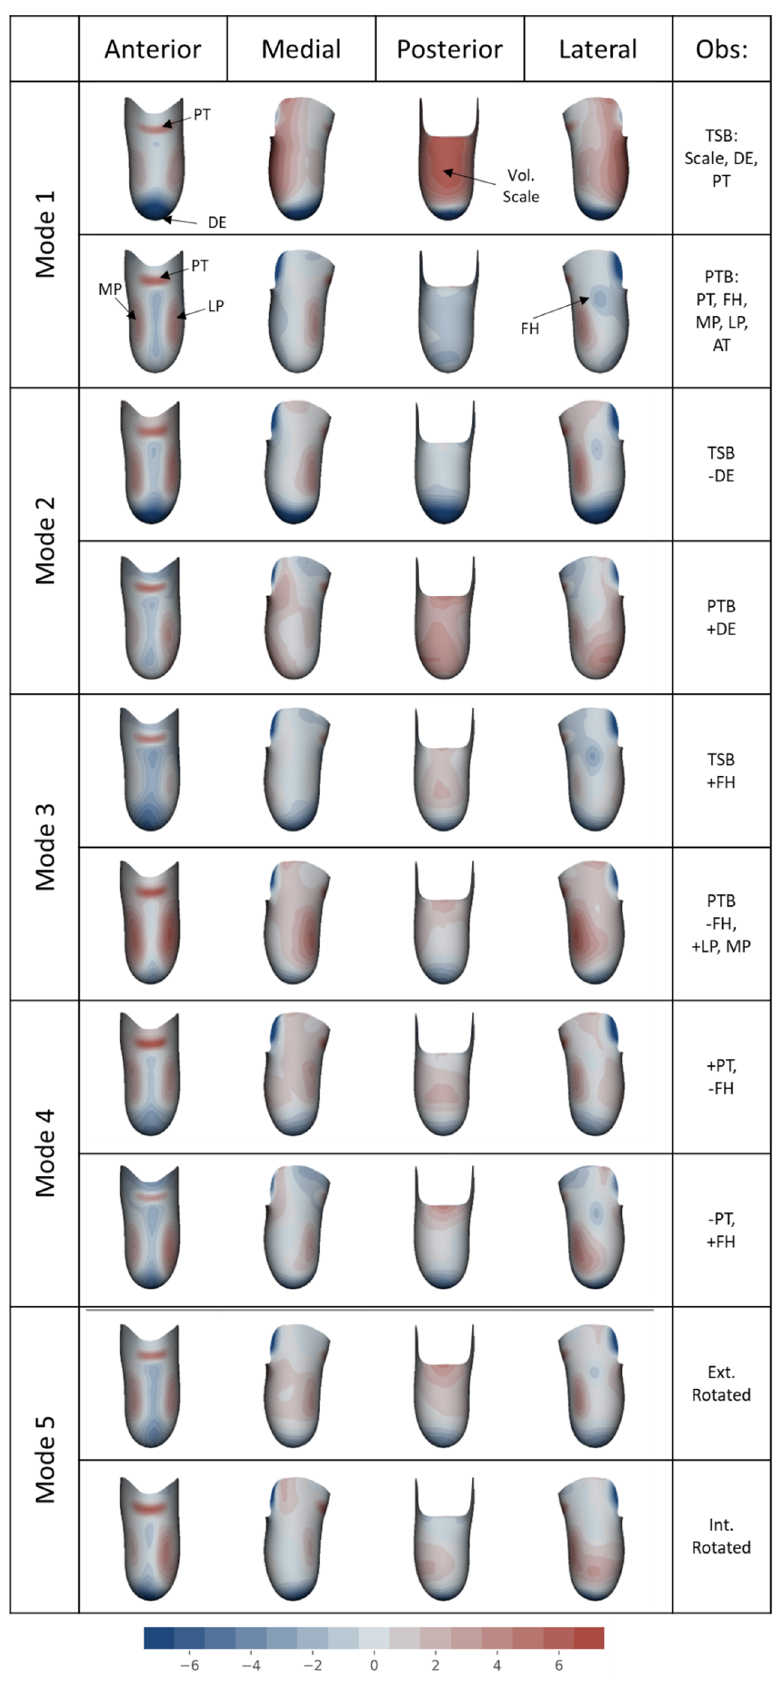
Figure 6. First five mode variations for the statistical design model (SDM), showing the 2.5th and 97.5th percentile shapes. Rectification map units: mm. Design variation Observations are labelled.